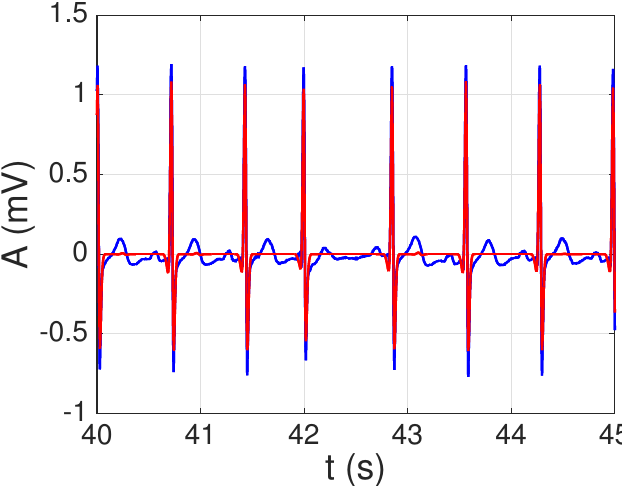
Figure 9. Example of sparse ECG representation with the derived dictionary for a segment of signal 121 from the PTB database. Real signal in blue; sparse representation (QRS complexes) in